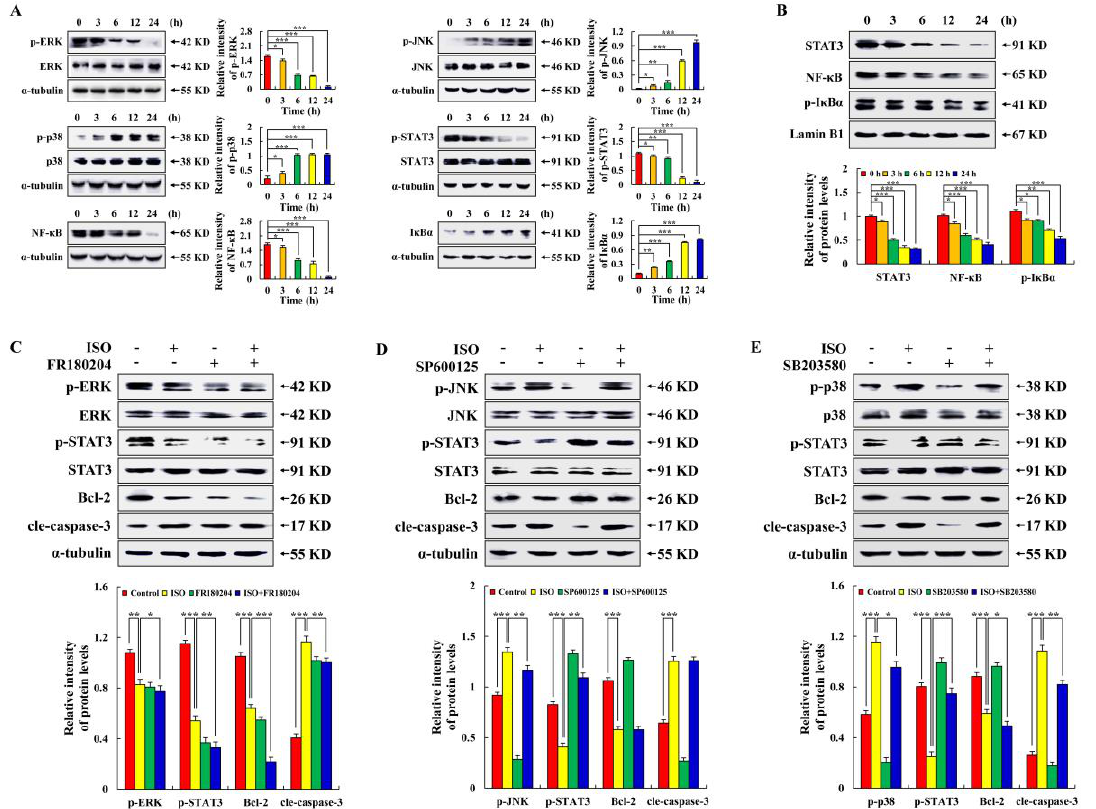
Figure 3. Regulation of ISO on the MAPK/STAT3/NF –κB signaling pathway in AGS cells. A total of 36.54 µM ISO was applied to AGS cells from 0 to 24 h. ( A ) MAPK/STAT3/NF –κB signaling pathway related protein expression level. ( B ) Nuclear protein expression level. ( C ) Expression levels of p–ERK, ERK, p – STAT3, Bcl – 2, and cle – caspase – 3 proteins in AGS cells treated with ISO (36.54 µM) and/or an ERK inhibitor (10 µ M). ( D ) Expression levels of p–JNK, p–STAT3, Bcl–2, and cle–caspase–3 proteins in AGS cells treated with ISO (36.54 µ M) and/or a JNK inhibitor (10 µ M). ( E ) Expression levels of p–p38, p–STAT3, Bcl–2 and cle–caspase–3 proteins in AGS cells treated with ISO (36.54 µ M) and/or a protein. * p < 0.05, ** p < 0.01 and *** p < 0.001 vs. 0 h or ISO + MAPK inhibition.